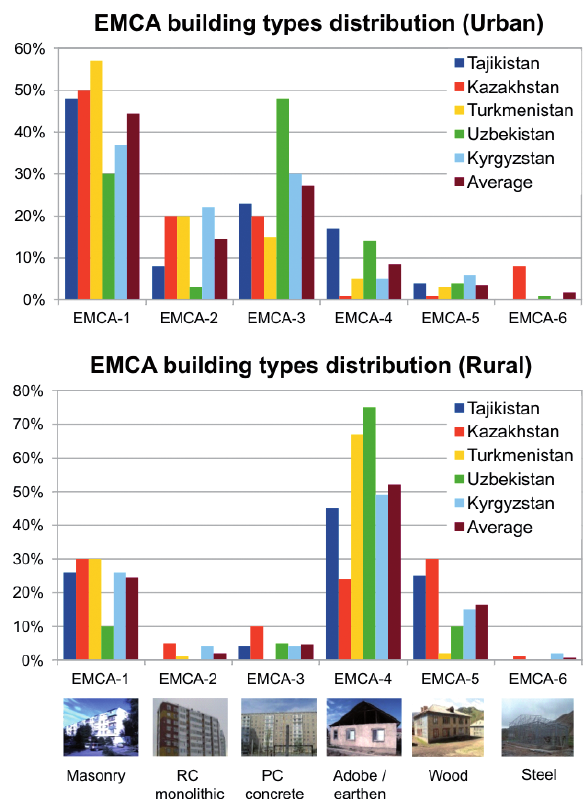
Figure 2. EMCA building type distributions for (a) urban and (b) rural areas in the different Central Asian